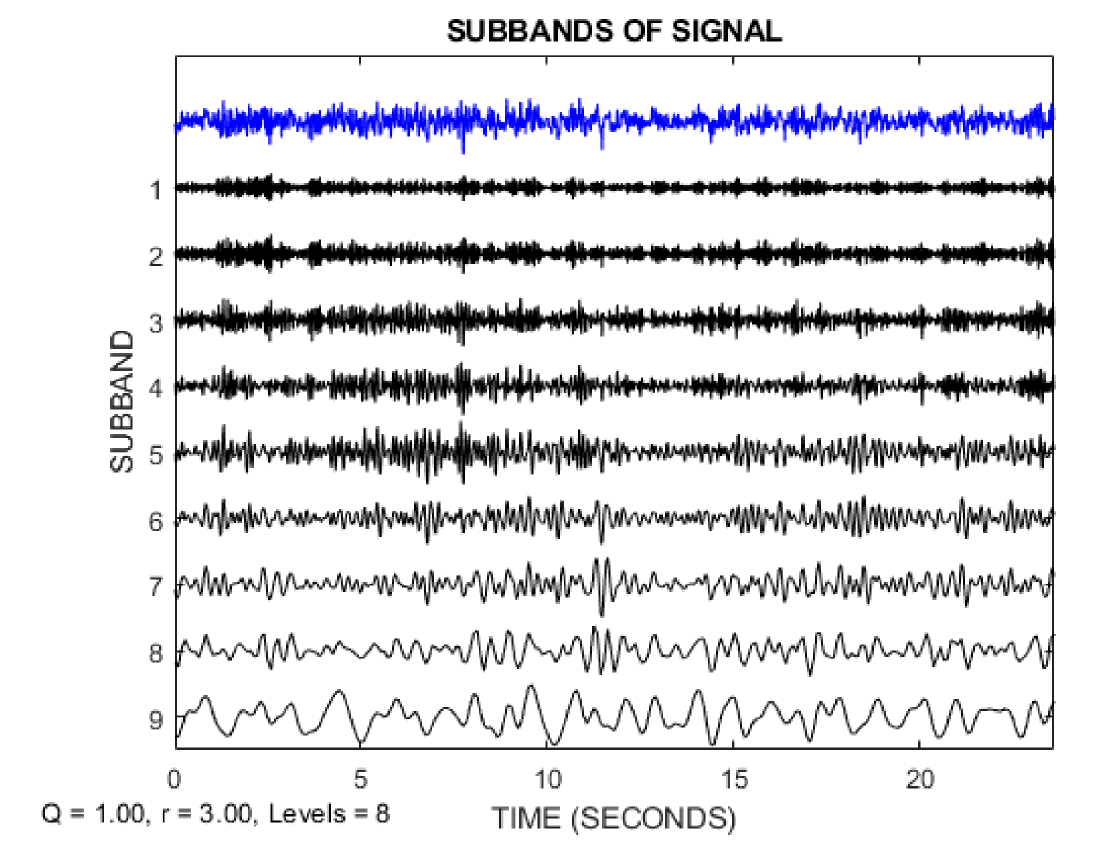
Figure 3. EEG signal decomposition using TQWT for the Bonn dataset.